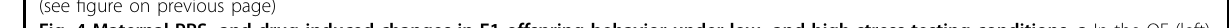
freezing during the average of the fi rst 3 tones compared = 288.6, p < 0.001) to the pre-tone period in males (F 1,78 = 240.0, p < 0.0001), and gradual and females (F 1,85 extinction of fear during the 7 subsequent tones in = 25.7, p < 0.001). Maternal PRS or males (tone, F 4.4,343.2